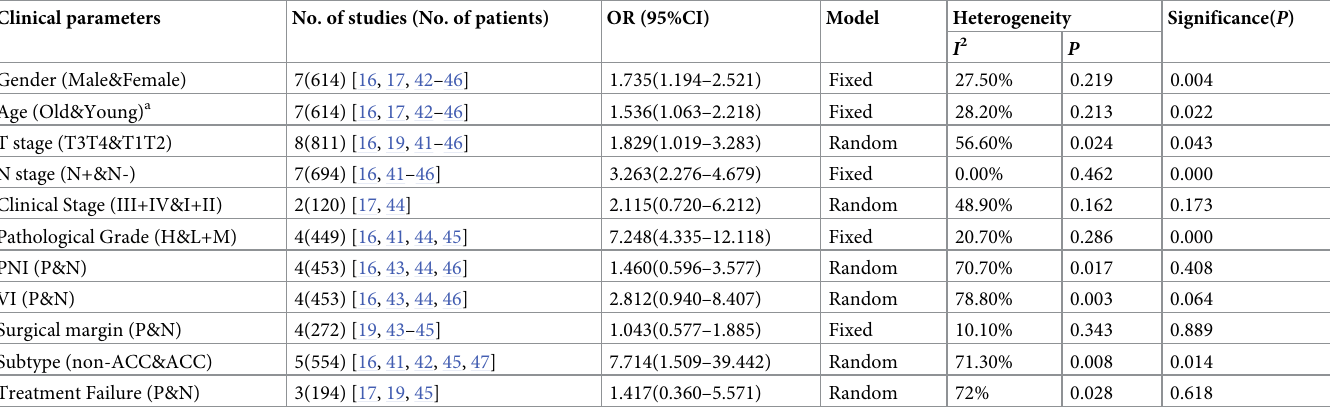
Table 2. Meta-analysis of PD-L1 expression and clinicopathological features in SGC patients. Clinical